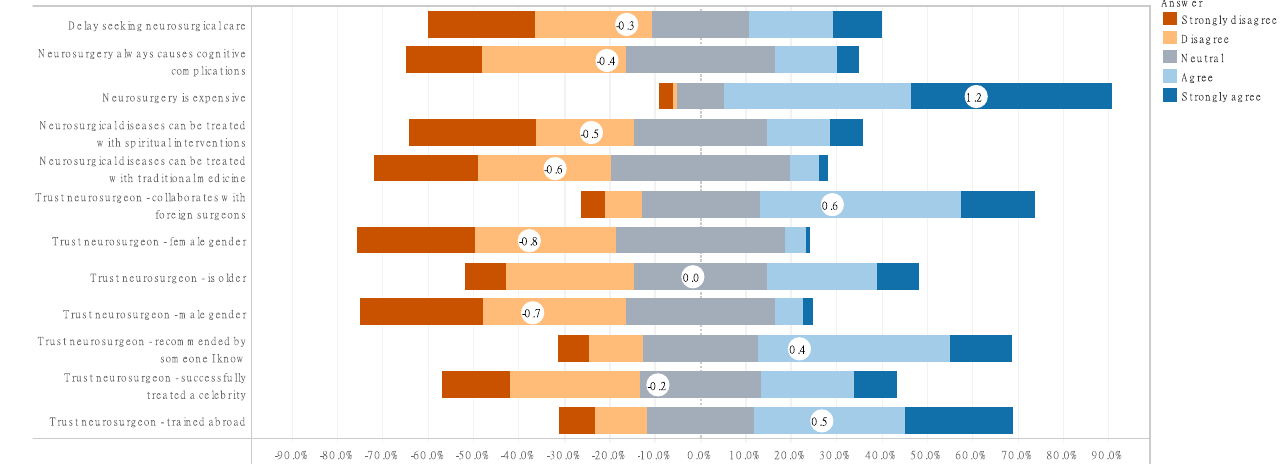
Fig 3. Diverging bar chart of Likert scale questions showing the percentage of respondents who agree or disagree with an assertion (bottom scale) and the average agreement score in white circles within the bar charts. Agreement levels were coded as Strongly disagree = -2, Disagree = -1, Neutral = 0, Agree = 1, and Strongly agree = 2. Hence, negative scores denote disagreement, and the more negative the score, the higher the disagreement. Similarly, positive scores represent